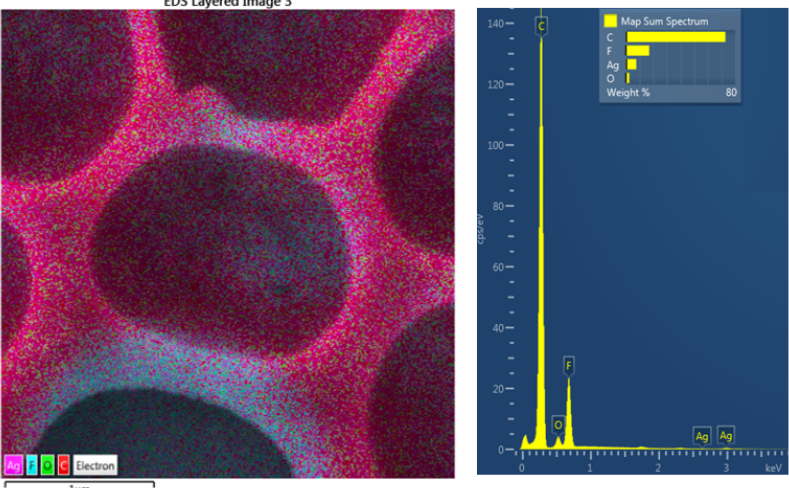
Figure 9. EDS mapping image superposed on SEM scan (3 × 3 micron square, on the left-hand side) of immobilized honeycomb pattern with silver, with EDS spectrum and corresponding elemental concentrations in this area.